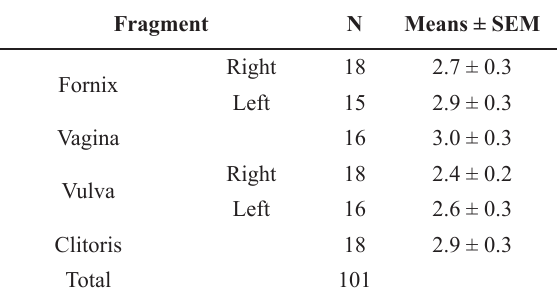
Distribution of microscopic lesion score in the fornix, cranial vagina and vulva of heifers with GVS and presenting positive culture for Ureaplasma